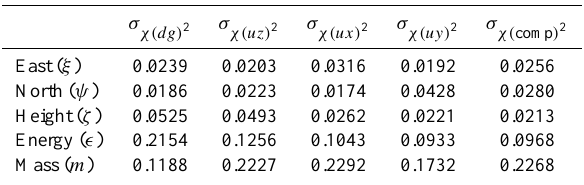
Table 6. Standard deviation of nonnormalized E-FAST TSIs with 30 different